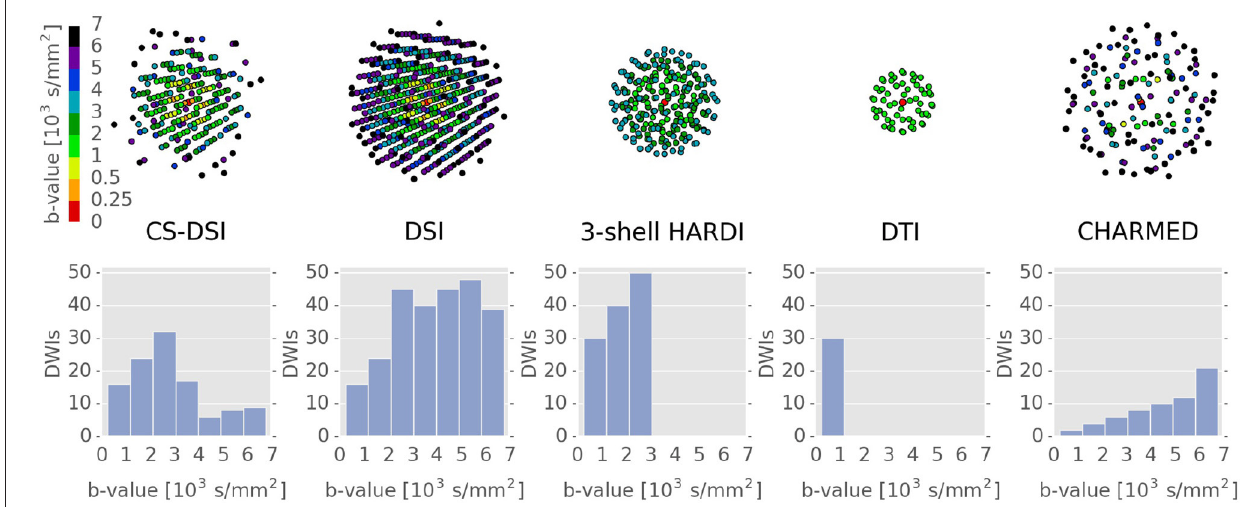
FIGURE 1 | DMRI sampling distributions and diffusion weighting of the advanced imaging protocols CS-DSI and 3-shell HARDI and of DTI and CHARMED schemes. (Top row) The color coding of the q-space samples highlights the range of b -values specific to each protocol. The number of depicted q-space samples per protocol corresponds to the sum of acquired DWIs and their antipodal counterparts. (Bottom row) The number of DWIs acquired per protocol is depicted as a function of the b -value. In contrast to the single (DTI) and the multi-shell (3-shell HARDI) scheme, CS-DSI, DSI and CHARMED contain high b -value